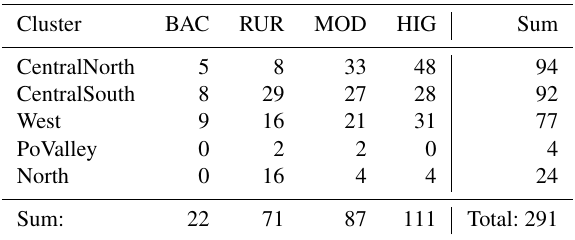
Table 1. Number of sites in each site group based on the LT (t) and S(t)